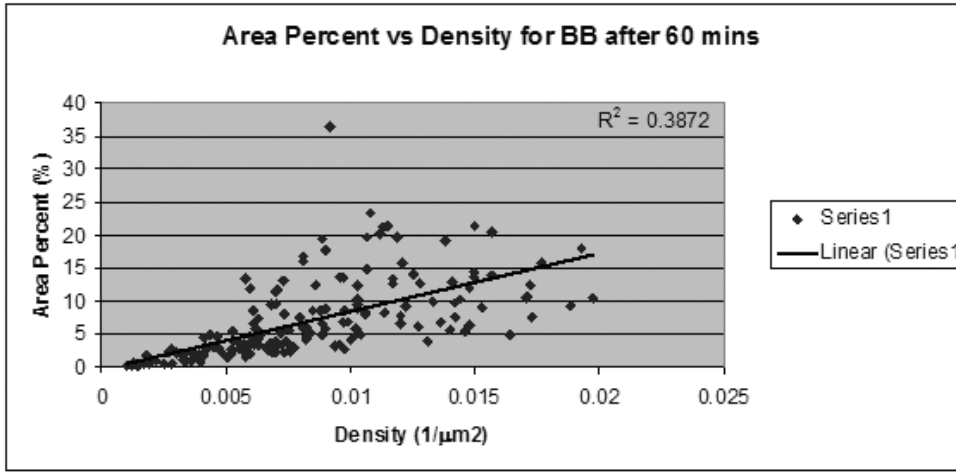
Figure 11: Area Percent vs. Density of wear for BB after 60 minutes.